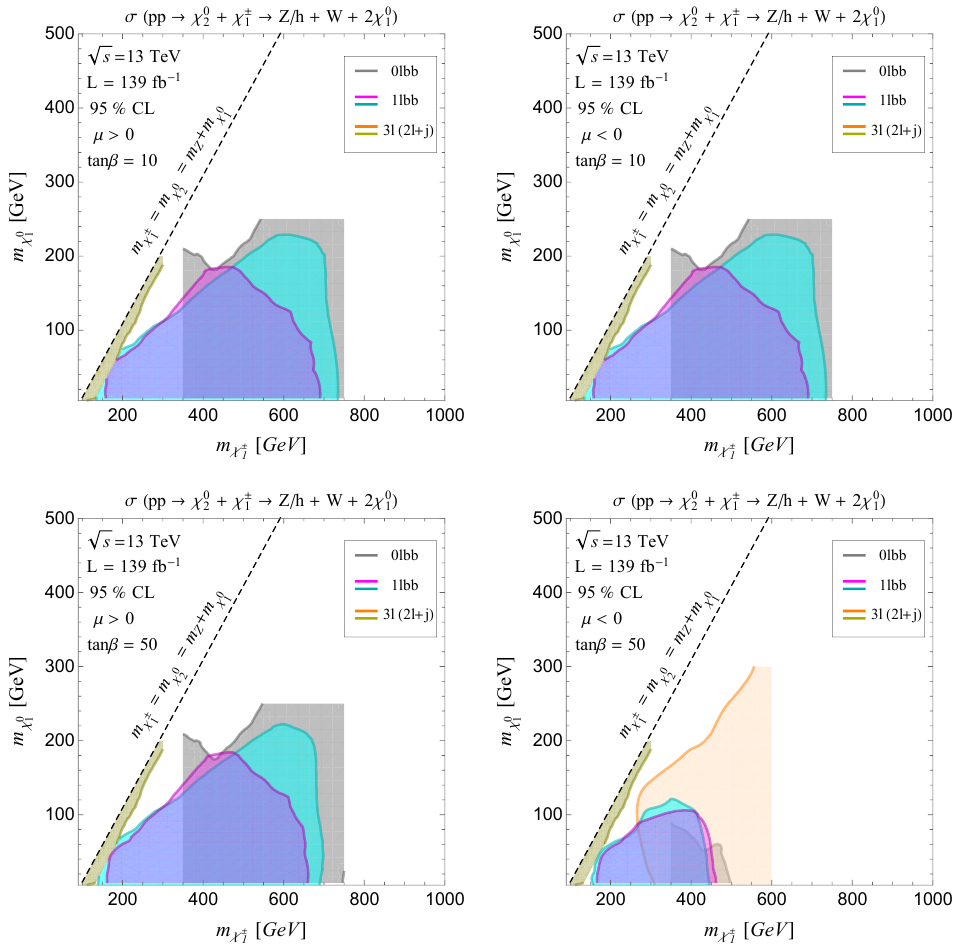
Figure 6 . 95% confidence level bounds on the Wino-Bino scenario projected for integrated lumi- nosity of L = 139 fb − 1 with M SUSY = | µ | = 10 TeV. The labels are similar to figure